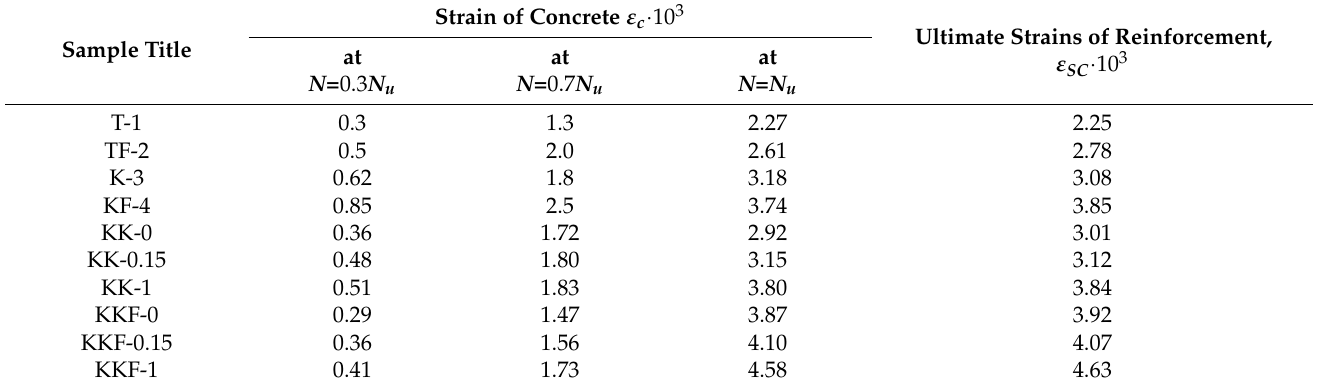
Table 9. Strains of concrete and reinforcement in experimental columns from heavy and light